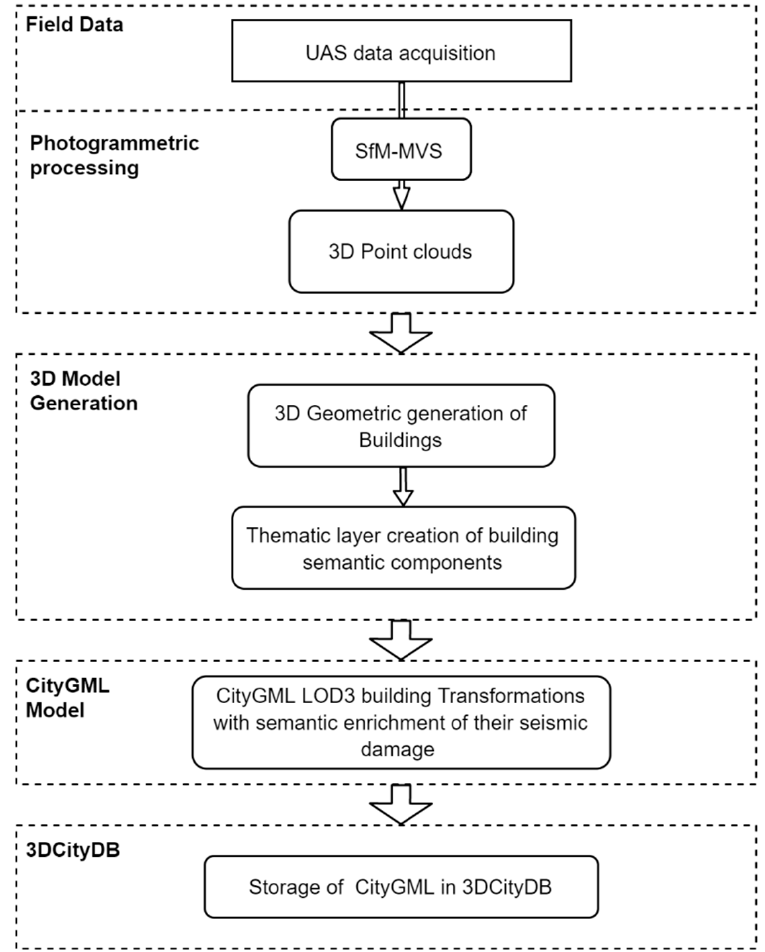
Figure 2. The workflow of the methodology implemented consists of five steps.